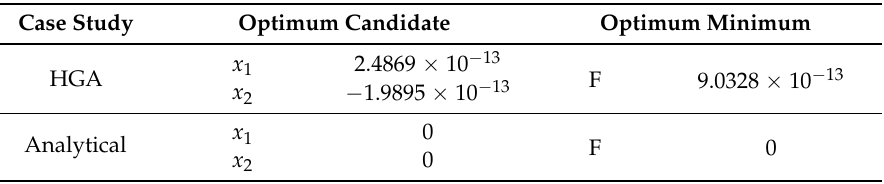
Table 6. Results for the Ackley benchmark case study.